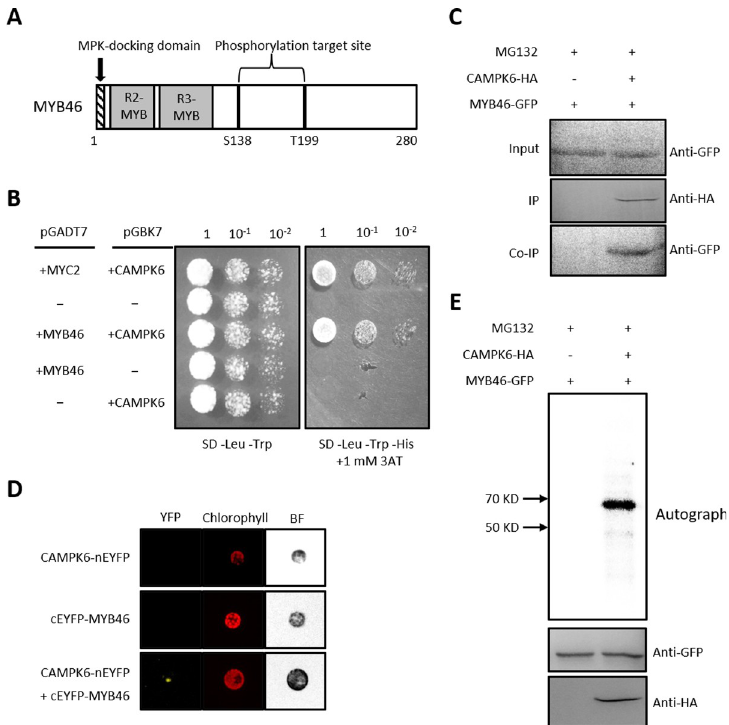
Fig 1. MPK6 phosphorylates MYB46 protein with a direct interaction. (A) Schematic drawing of MPK docking domain and phosphorylation target sites in MYB46 predicted by Eukaryotic Linear Motif (http://elm.eu.org/). (B) Yeast two hybrid assay showing interaction between MYB46 and CAMPK6 proteins. A standard spot assay was carried out using the designated selective media condition (-Leu, -Trp, -His in the presence of 1 mM 3AT). (C) Co- immunoprecipition of MYB46 and CAMPK6. GFP conjugated MYB46 (MYB46-GFP) and HA conjugated CAMPK6 (CAMPK6-HA) were co-expressed in AMPs with MG132 treatment. After expression, immunoprecipitation was carried out with anti-HA antibody and then protein blot analysis was carried out with anti-GFP antibody. (D) Bimolecular fluorescence complementation (BiFC) of MYB46 and CAMPK6. BiFC was carried out with designated combinations in AMPs with MG132 treatment. (E) Immunocomplex kinase assay of MYB46 and CAMPK6. MYB46-GFP and CAMPK6-HA were expressed in AMPs. After the expression, immunoprecipitation was carried out with anti-HA antibody and anti-GFP antibody, then in vitro kinase assay was carried out.